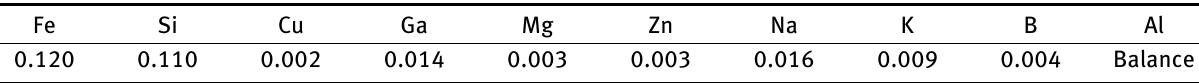
Table 1: Composotion of commercial purity aluminum (wt.%).